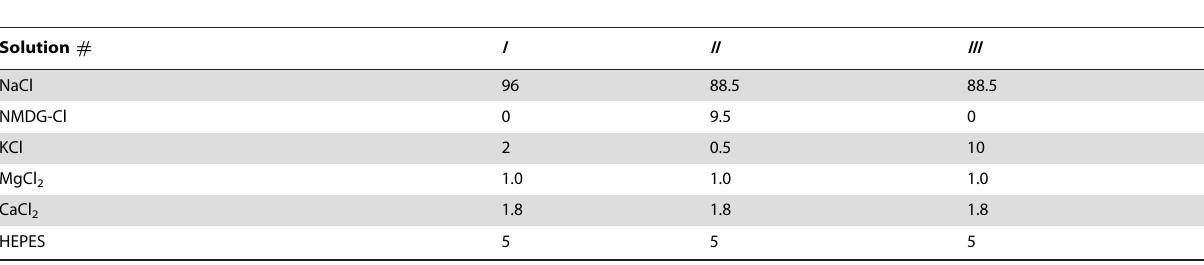
The pH of all solutions was adjusted to 7.5 with NMDG-OH. The osmolality of each solution was verified to be 190 mOsm kg 2 1 H 2 O ( 6 5 mOsm kg 2 1 H 2 O) by vapor pressure osmometry.